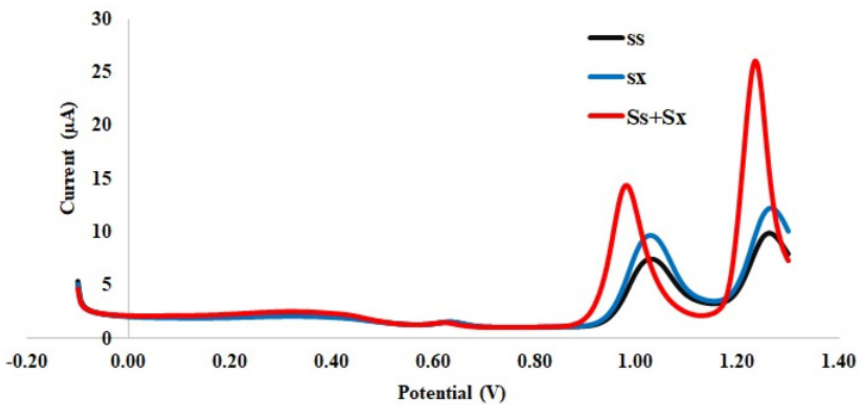
Figure 6. Differential pulse voltammograms of Pt-Pd-modified glassy carbon electrode A; in BR buffer pH solutions containing standard ABZ (S s ), unknown ABZ (S x ), and a mixture of the standard and the unknown (S s + x ).